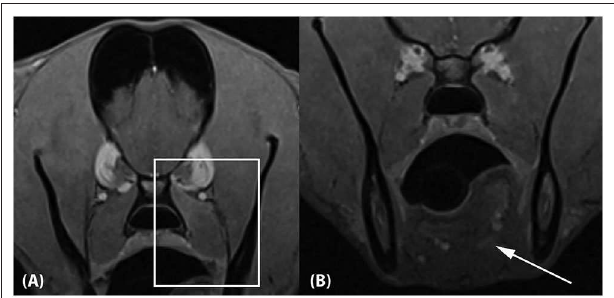
FIGURE 4 | Approximately 10-week recheck MRI examination of the head. (A) Transverse T1-weighted Volume Interpolated GRE images with fat saturation (“VIBE”) at the level of the previous medial pterygoid muscle lesion and (B) the previous tongue base lesion. The lesions have mostly resolved, with mild residual contrast enhancement noted associated with the dorsal aspect of the left medial pterygoid muscle ( A ; box) and the tongue base ( B ; arrow). The left medial pterygoid muscle is mildly decreased in size compared to the